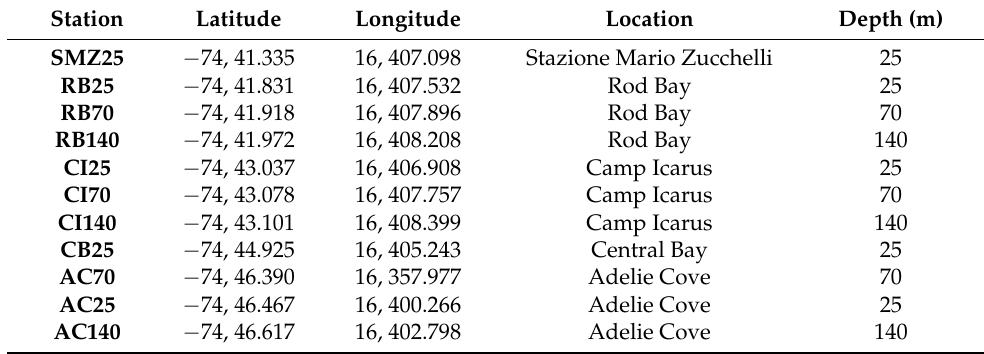
Table 1. Coordinates, location and depth of the 11 sampling